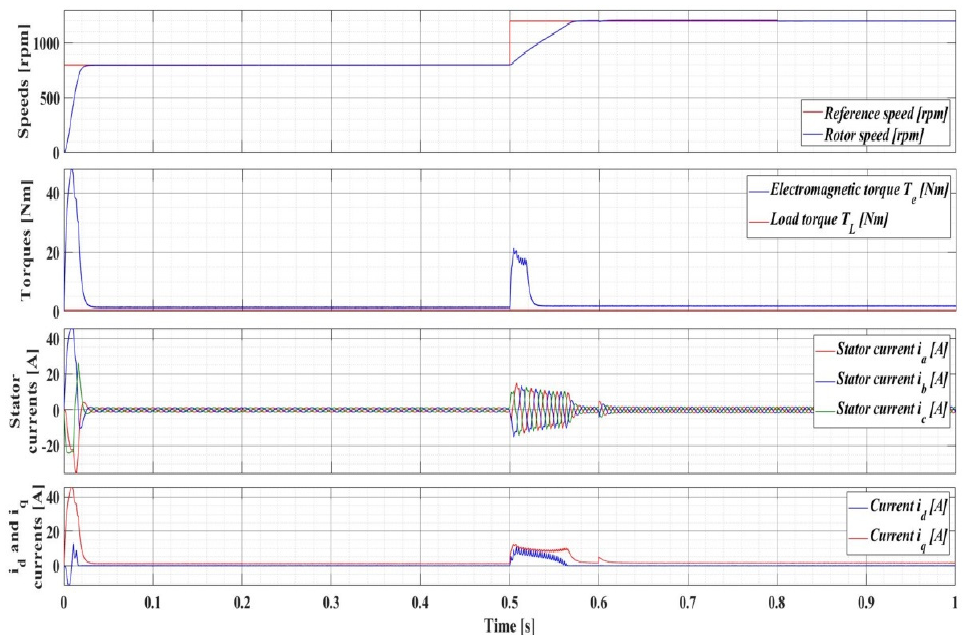
Figure 25. Time evolution for PMSM control system based on FOC-type strategy for PMSM with variable structure and switching signal type 2, ω ref = [800 1200] rpm, and T L = 0.5 Nm.